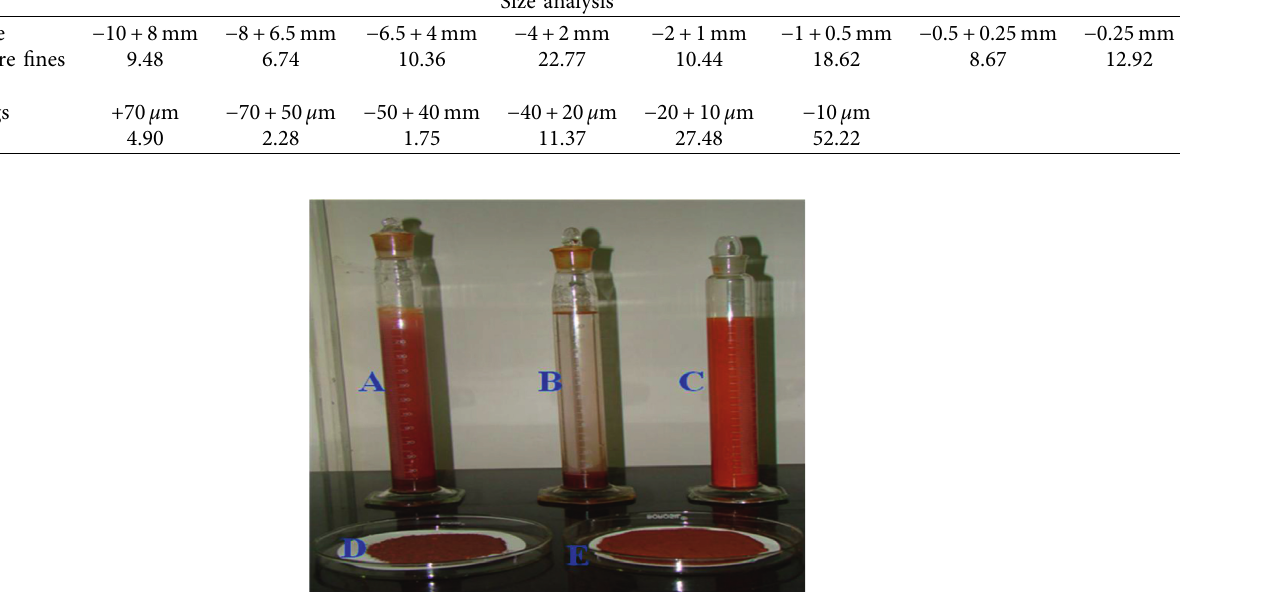
Figure 1: Snapshot of (A) iron ore slime suspension with 5ppm AD 200, (B) suspension without surface-active agent, (C) dispersed phase, (D) concentrate, and (E) feed. Table 2: Chemical analysis (wt. %) of the feed of iron ore fines and slime (wet chemical